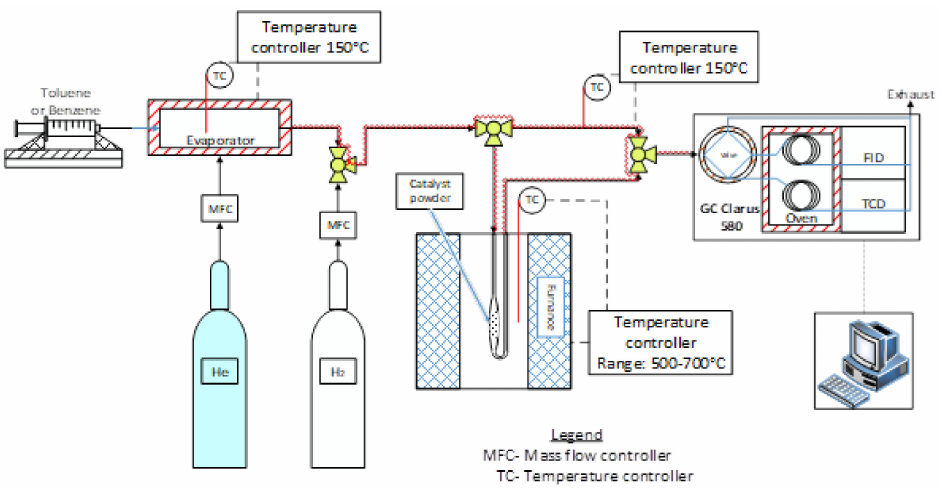
Figure 10. Representation of lab-scale workplace for tar